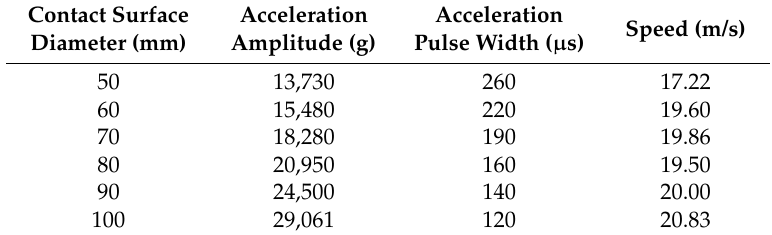
Table 3. Influences of different contact areas on excitation pulse width during collision. Contact Surface